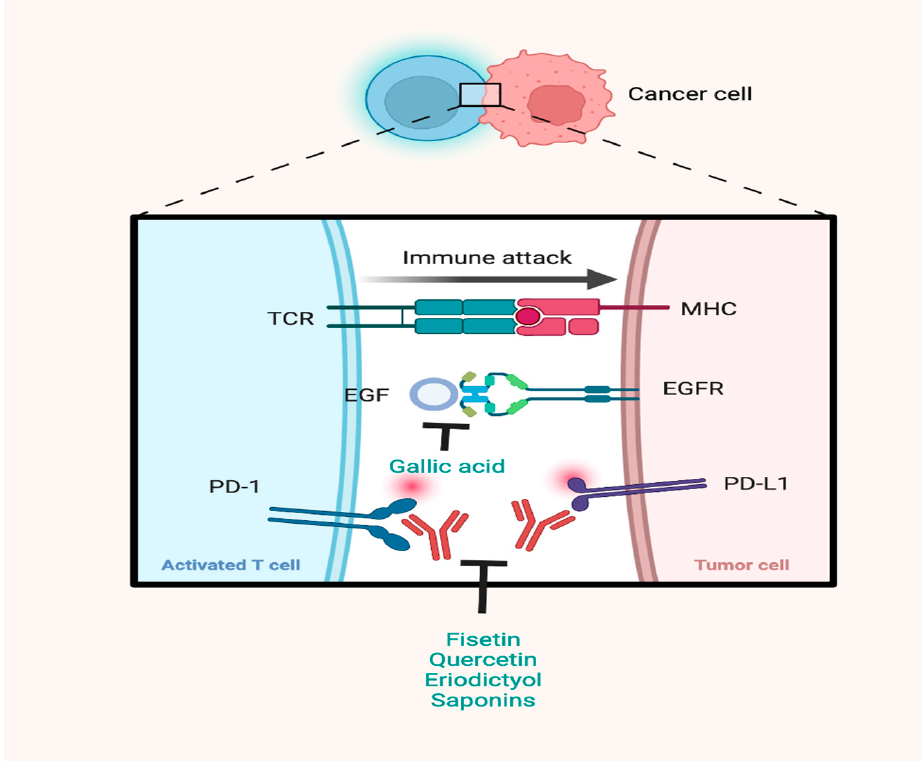
Figure 1. Schematic figure representing some interactions between phytochemicals, T ‐ cells, and cancer cells. Phytochemicals have been suggested to have the potential to modulate the therapeutic effects of immune checkpoint inhibitors and PD ‐ L1 expression through the regulating of several signaling pathways, such as EGFR / Akt. Some phytochemicals can regulate PD ‐ L1 expression, while others inhibit PD ‐ L1 glycosylation or PD ‐ L1 / PD ‐ 1 binding, such as quercetin, saponins, and fisetin. Abbreviations: EGF: epidermal growth factor; EGFR: epidermal growth factor receptor; MHC: major histocompatibility complex; PD ‐ 1: programmed cell death protein 1; PD ‐ L1: programmed death ligand 1 (PD ‐ L1).